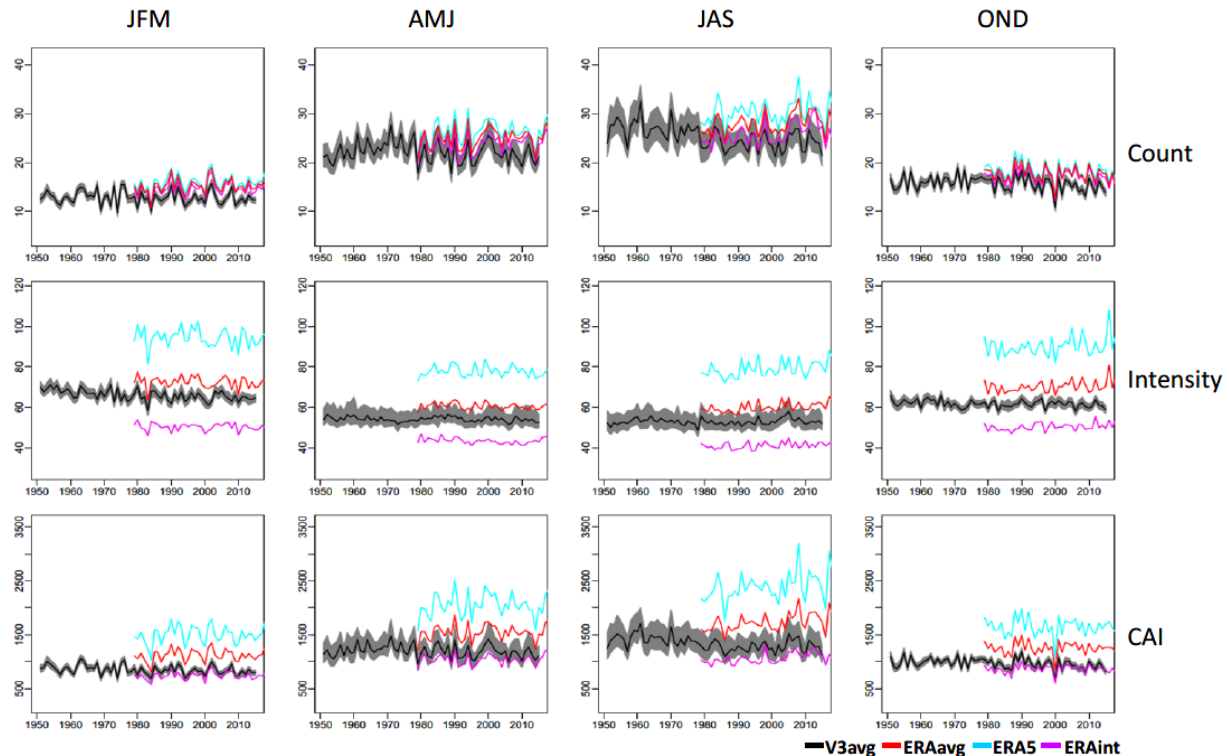
Figure 4. Time series of the seasonal mean cyclone count (per 250 km grid-box; ( top panels )), intensity (unit: 10 −5 hPa km −2 ; ( middle panels )), and CAI (per 10 6 km 2 ; ( bottom panels )) over the northern extratropical land. Results in JFM, AMJ, JAS, and OND are shown from left to right. The horizontal axis is the year. Results of the ensemble mean (relatively smooth black curve within the grey shading) and ensemble standard deviation (grey shading) are given for 20CRv3 over the period 1951–2015. Results from ERAint (magenta curve) and ERA5 (light blue curve), as well as their average (ERAavg; red curve), over the period 1979 – 2018, are also shown.